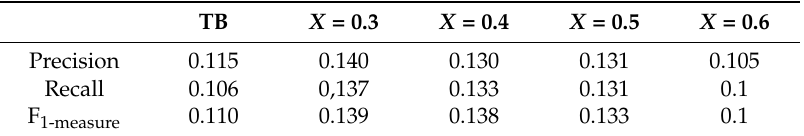
Table 2. The experimental results of precision, recall, and F 1-measure in the baby products shop. TB X = 0.3